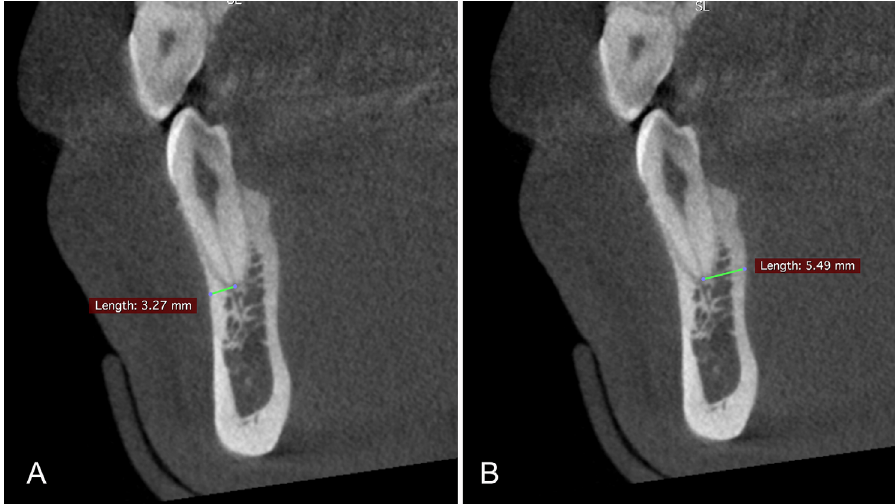
Figure 2- The smallest measurement for the anterior teeth was found in the sagittal plane (buccal and lingual bone